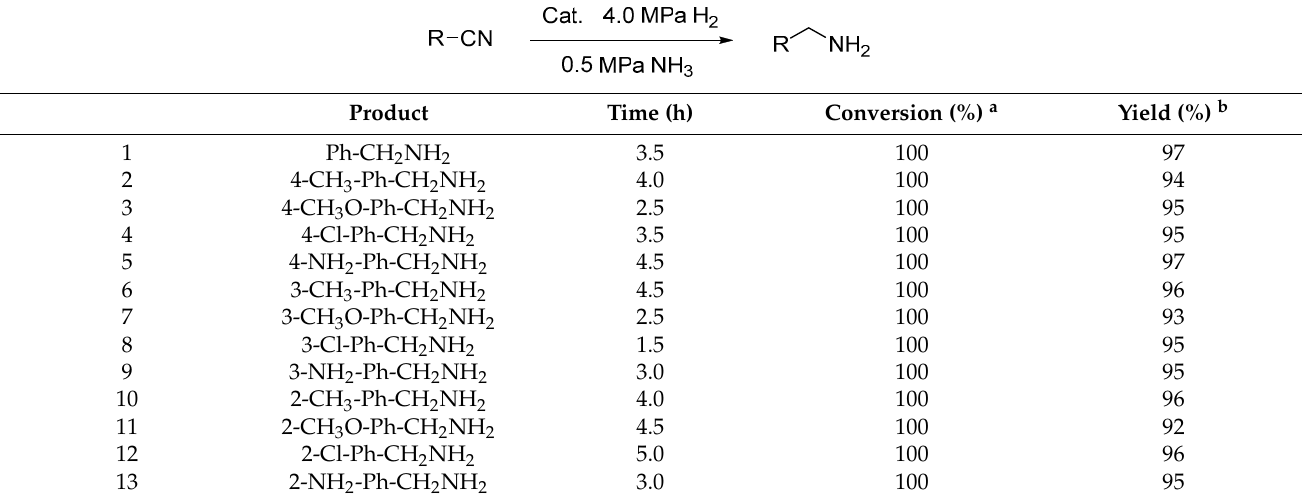
Table 4. Hydrogenation of nitriles catalyzed by Ni 12.4 -30.